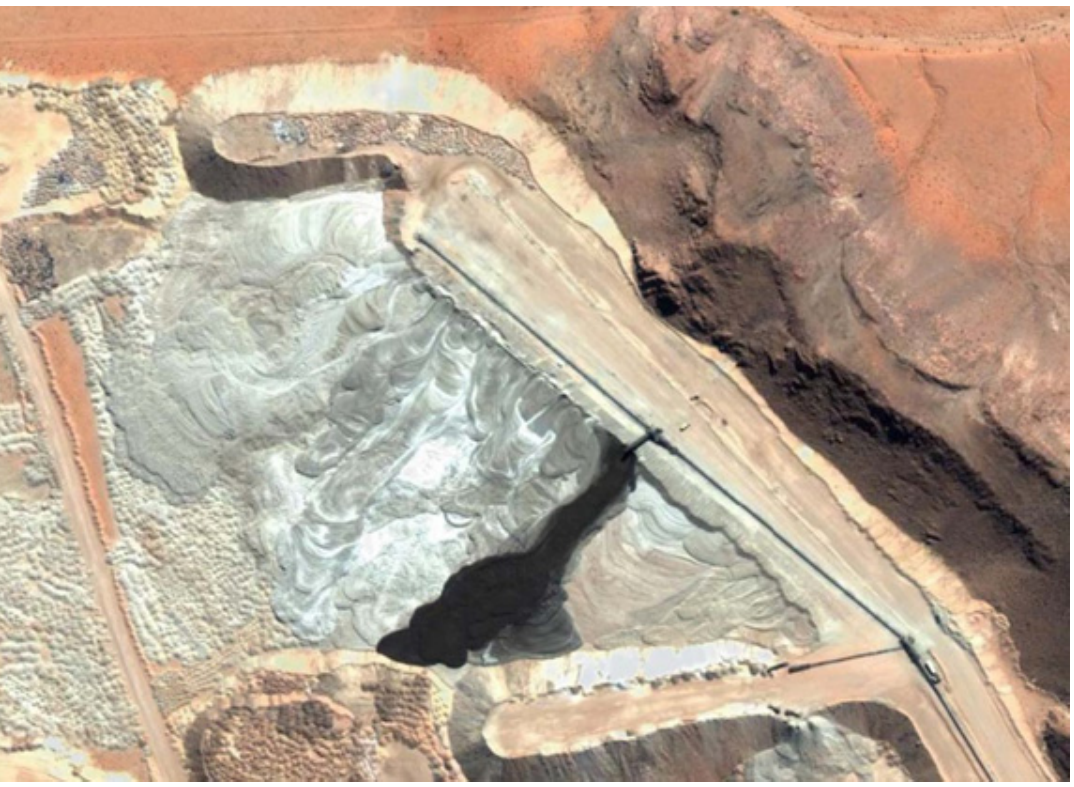
Figure 50. Mantos Blancos Aerial View of Disposal of Filtered Coarse Tailings [18,67,68].